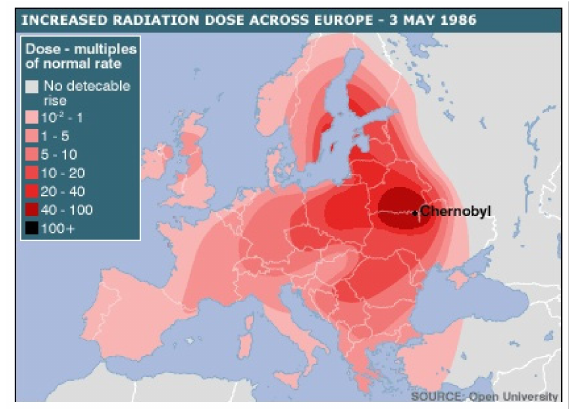
Figure 1. Chernobyl fallout radiation cloud on 3 May 1986 covering a map of Europe